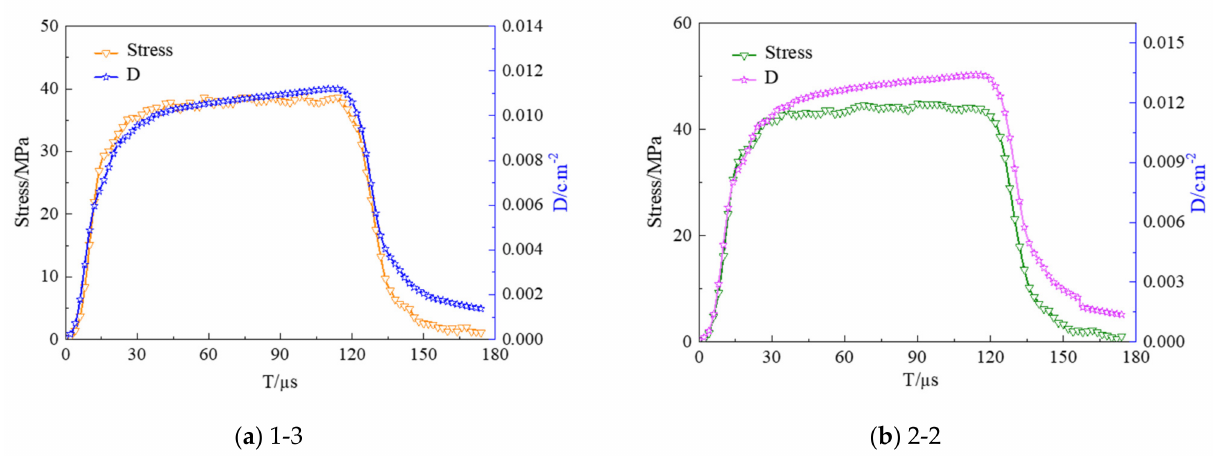
Figure 8. Time curves of the stress and electric displacement of the composite.